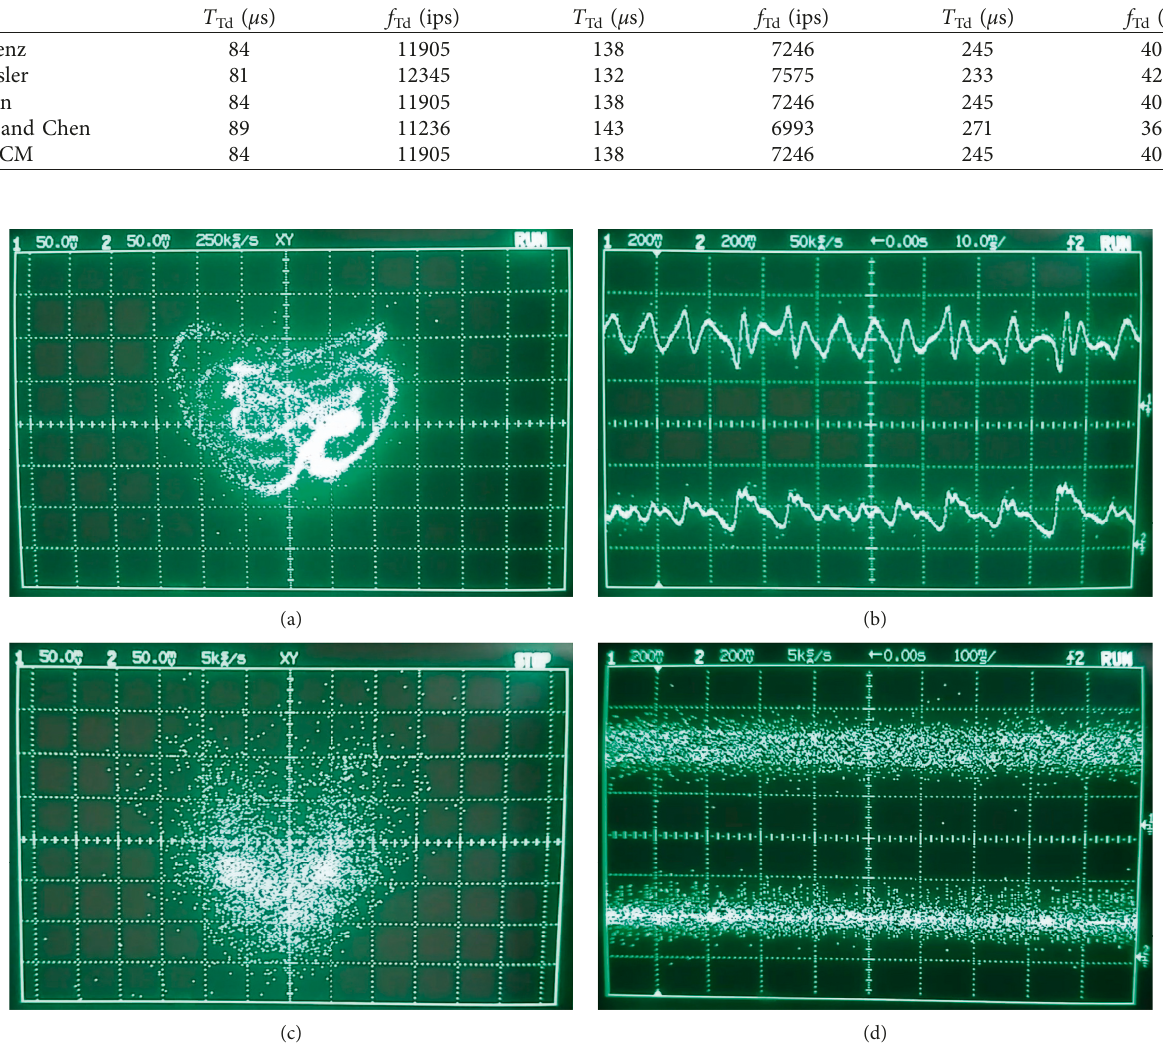
Figure 12: Implementation of ES in the V3 of Chen CS (18) and (19) in its DV. (a) Phase plane x ( n ) versus z ( n ) , (b) evolution of state variables x ( n ) and z ( n ) by using τ � 0.001, (c) phase plane x ( n ) versus z ( n ) , and (d) evolution of state variables x ( n ) and z ( n ) by using τ max � 0.017. Table 9: Performance of ES in the V3 of the 3D Lorenz, R¨ossler, Chen, Liu and Chen, and MACM CSs in their DVs by using